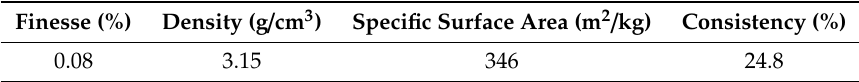
Table 2. Properties of